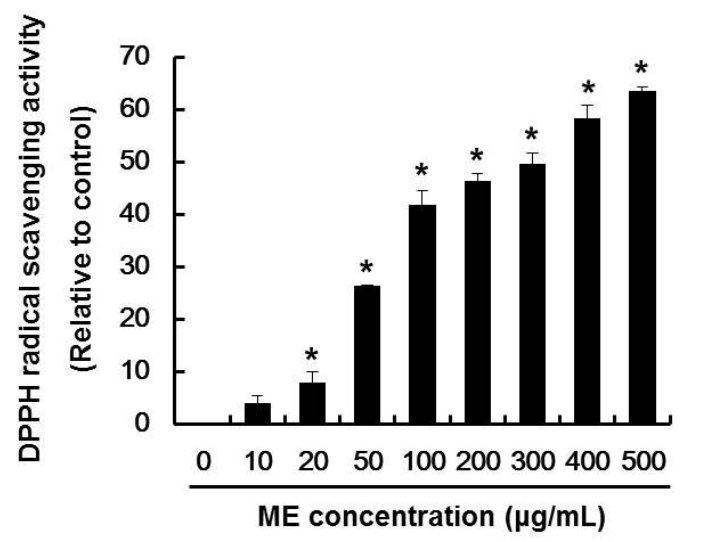
Figure 1. DPPH radical scavenging activity of ME. The amount of DPPH radicals was determined spectrophotometrically at 520 nm. Data represent the mean ± SE of three independent experiments. Significance of the differences were compared with the non-treated group at * p < 0.05 by Student’s t